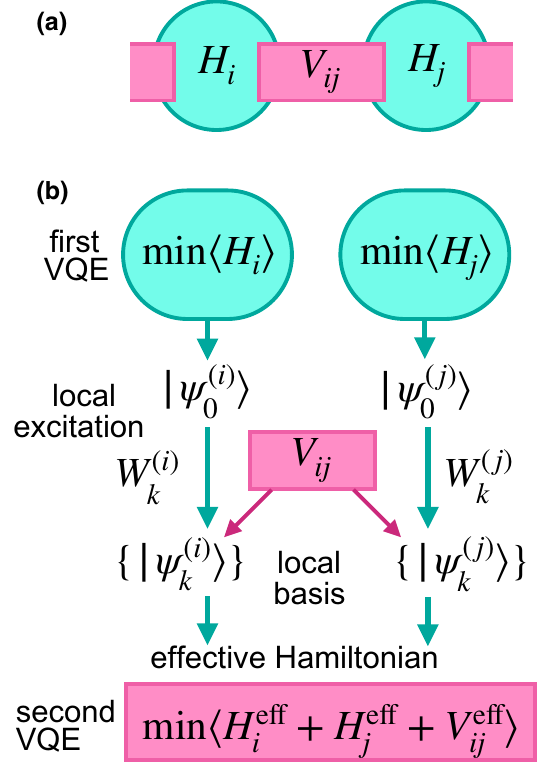
FIG. 1. (a) The system consists of subsystems of Hamiltonian H i , each of which interact with each other by intersubsystem interaction V ij . (b) To solve the system depicted in (a), we first (cid:2) of each H construct an approximate ground state | ψ ( i ) i with 0 VQE (the first VQE). Then we form a basis set by applying exci- (cid:2) . Using the basis, we can construct an tation operators on | ψ ( i ) 0 effective Hamiltonian, which gives better approximation of the ground